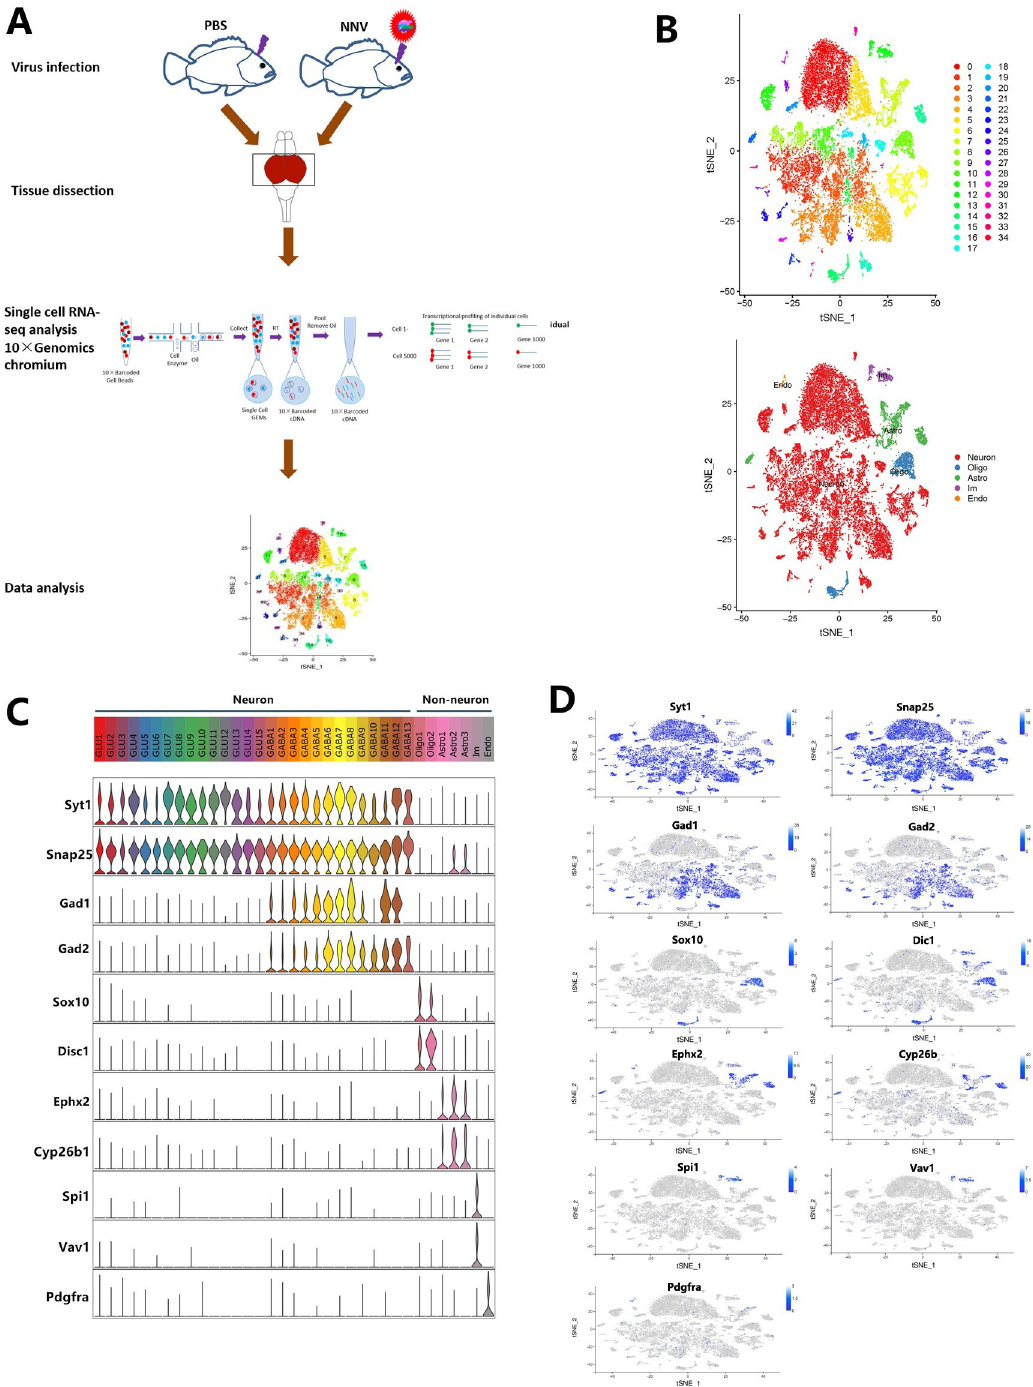
Fig 2. Cell sorting and categorization of cell types in the grouper midbrain. (A) Overall strategy for cell sorting and single-cell data analyses. (B) The tSNE plot clustering of cells (top): different cell clusters are color coded; in the tSNE plot showing expression of pan marker genes in distinct cell clusters (bottom), the gene expression level is color coded. (C) Violin plot showing the expression of pan marker genes across the 35 cell clusters. Each cluster is color coded. Snap25 and Syt1, pan-neuronal markers; Gad1 and Gad2, GABA neuronal markers; Sox10 and Disc1, oligodendrocyte (Olige) markers; Ephx2 and Cyp26b1, astrocyte (Astro) markers; Spi1 and Vav1, immunology (Im) cell markers; Pdgfra, endothelial (Endo) cell marker. (D) tSNE plots showing expression of pan marker genes in distinct cell clusters. The gene expression level is color